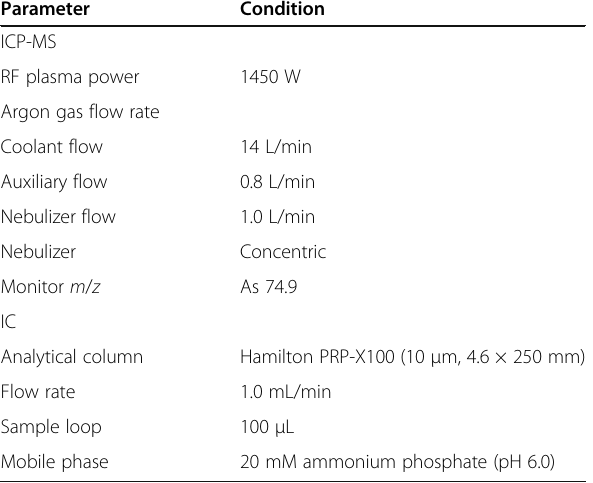
Table 2 Operating parameters for